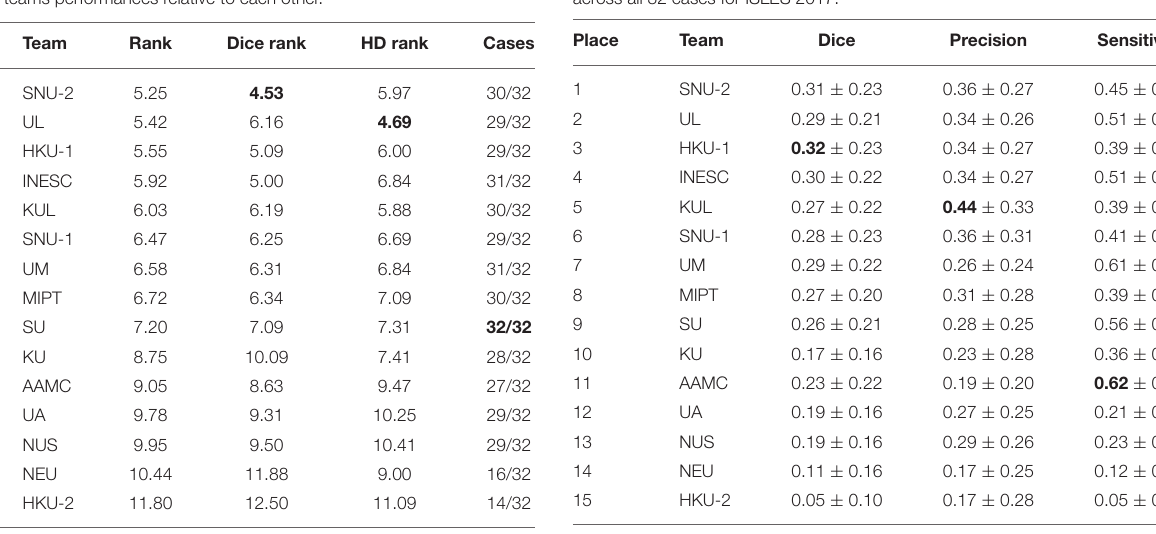
Dice and HD rank are the average achieved ranks for each participating team. The cases columndenotesthenumberofsuccessfully(DC > 0)predictedlesions.Bestmeanvalues printed in bold.